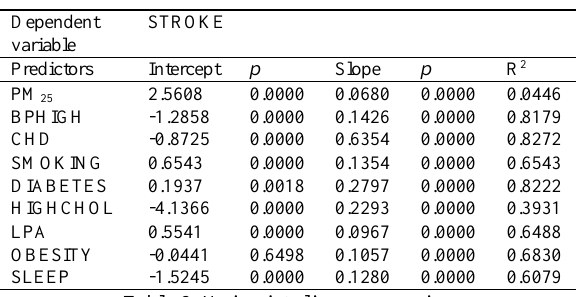
Figure 3. Regularization path for the elasticnet penalty. Each curve corresponds to a predictor variable. It shows the path of its coefficient against log lambda (lambda is a complexity parameter: λ≥0). 1 – BPHIGH, 2-CHD, 3-SMOKING, 4-